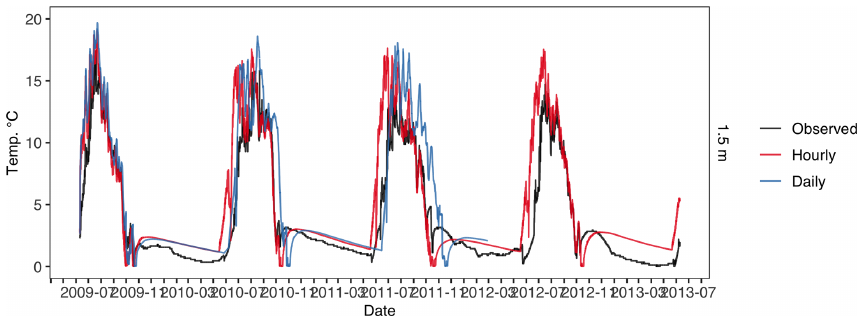
Figure F3. Fox Den 1.5m water temperature across different temporal resolution simulations. Observed water temperature is in black, hourly temporal resolution is in red, and daily temporal resolution is in